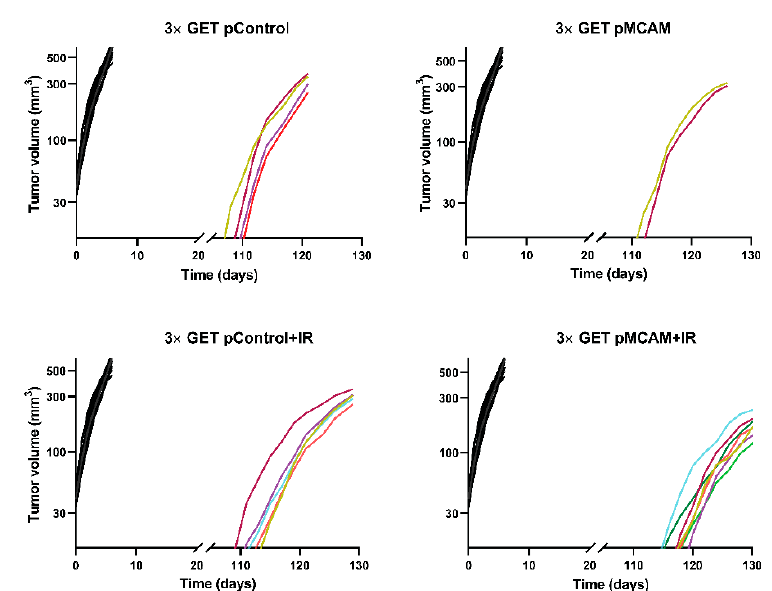
Figure 4. Tumor growth of individual B16F10 melanoma in mice that were re-challenged with tumors cells after being in complete response for 100 days. Animals that were cured for 100 days after the primary treatment were challenged with a secondary subcutaneous injection of the tumor cells ( n = 2–7). The primary treatments that resulted in tumor cures are labeled in the graph title and were: GET pMCAM; GET pControl; GET pMCAM+IR; GET pControl+IR; all colored lines. The control naïve group ( n = 18, black lines) represents the growth rate of individual tumors after the first inoculum, which received only tumor cells, the same as the re-challenged mice.